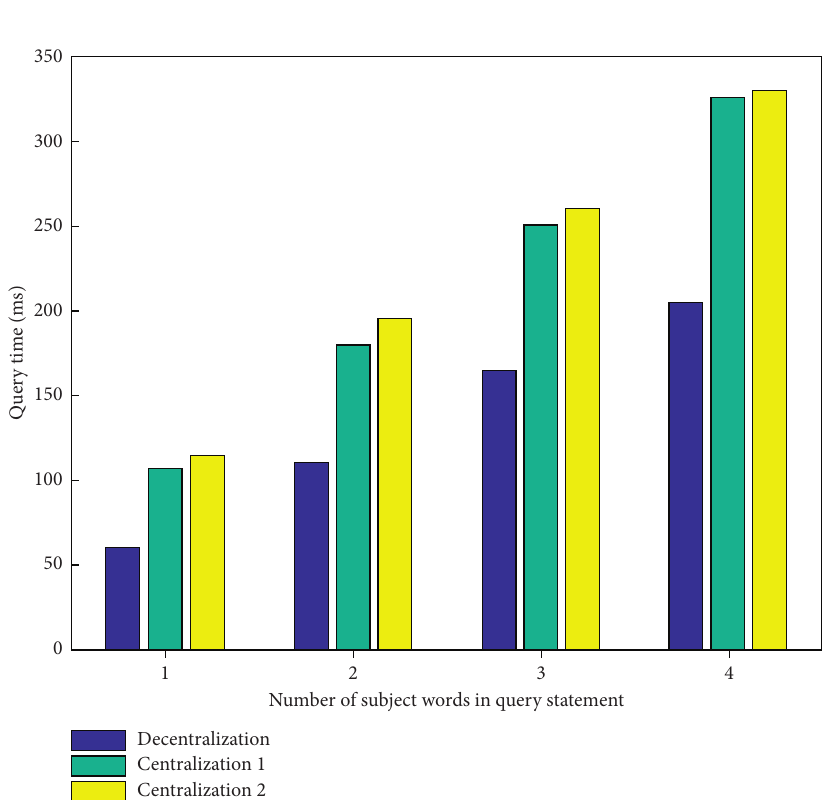
Figure 5: Rate comparison (data